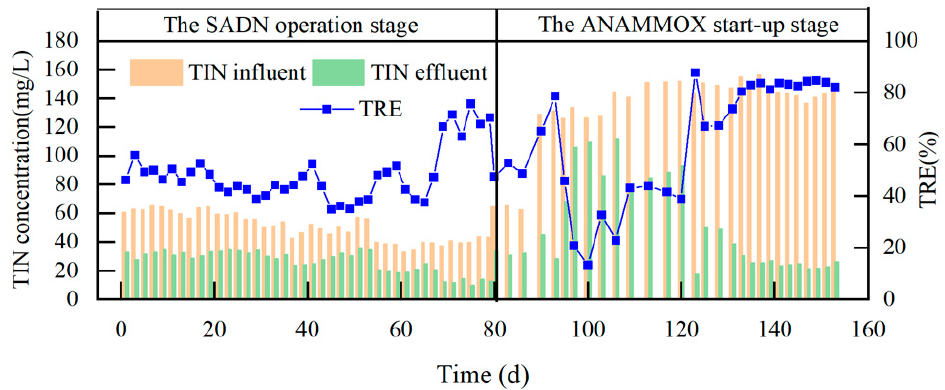
Figure 9. Variations of TIN and TRE during the S 0 -SADN operation stage and the ANAMMOX start-up stage.